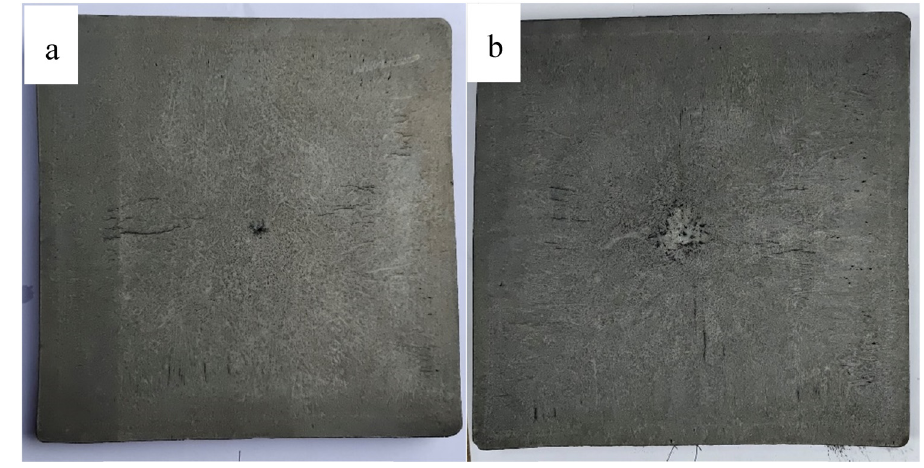
Figure 8: Defect detection diagrams of billet at di ff erent casting speeds: ( a ) 1.6 m · min − 1 and ( b ) 2.0 m · min − 1